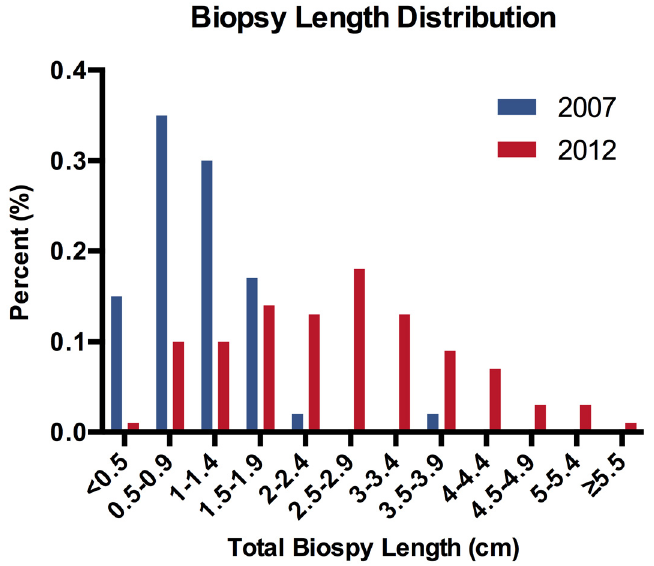
Fig 2. Distribution frequency of total biopsy sample size for 2007 (blue) and 2012